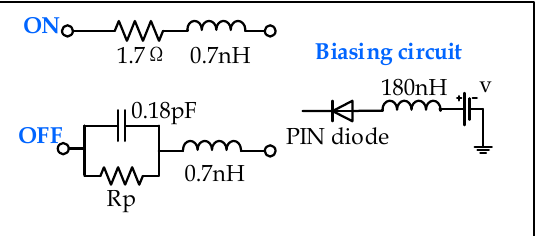
Figure 2. On/off equivalent model of the SMP1331-079LF p–i–n diode and schematic of the basing circuit.